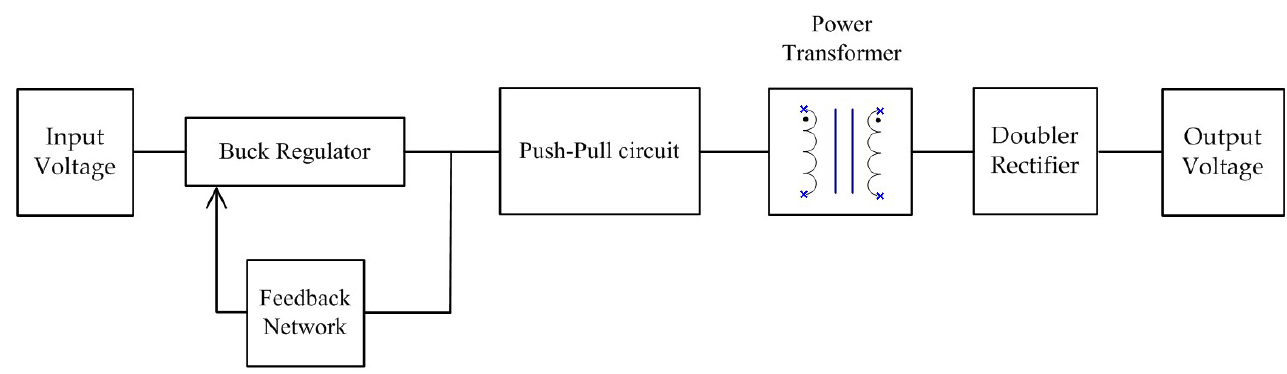
Figure 2. The block diagram of the two-stage converter.